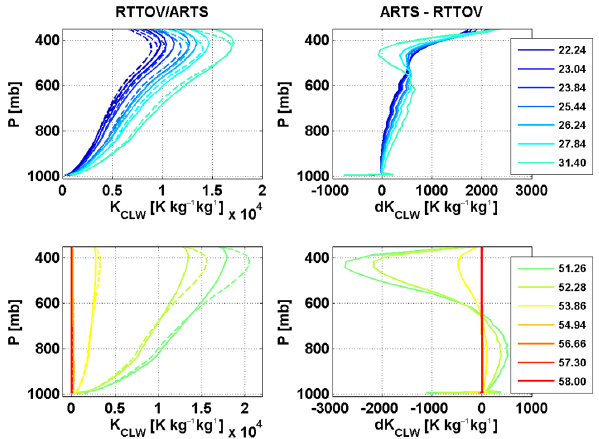
Figure 10. As in Fig. 8, but for Jacobians calculated with ARTS (solid line) and the RTTOV-gb K-module (dashed